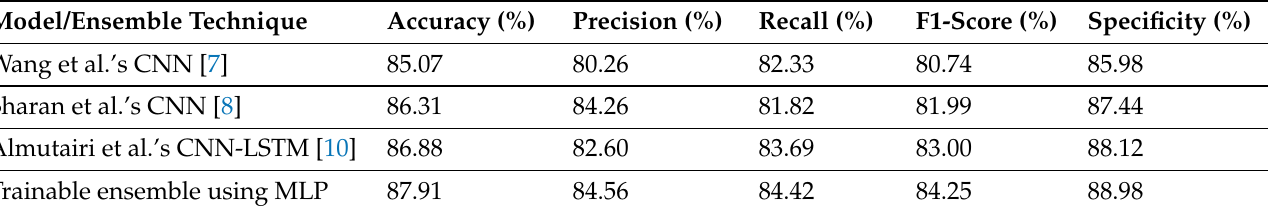
Table 4. Classification performances obtained by all the base models and their ensemble using five-fold cross-validation.